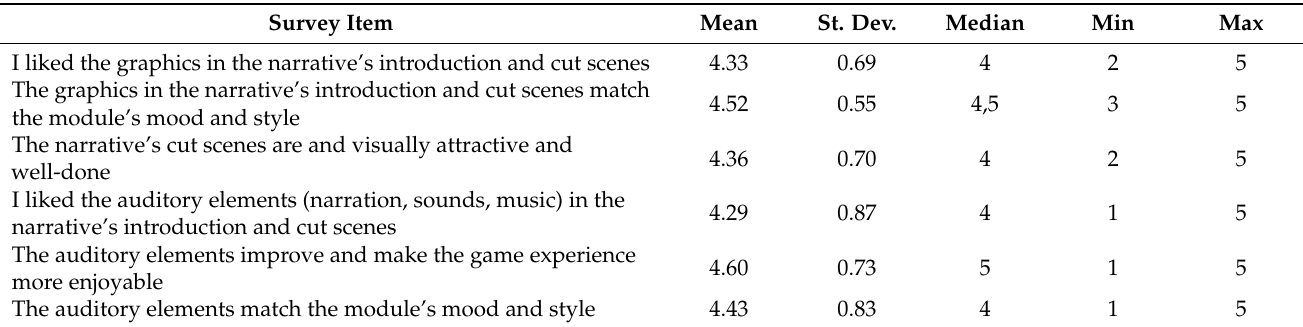
Table 5. Descriptive statistics on the evaluation and alignment of technical elements of playful courses. Survey